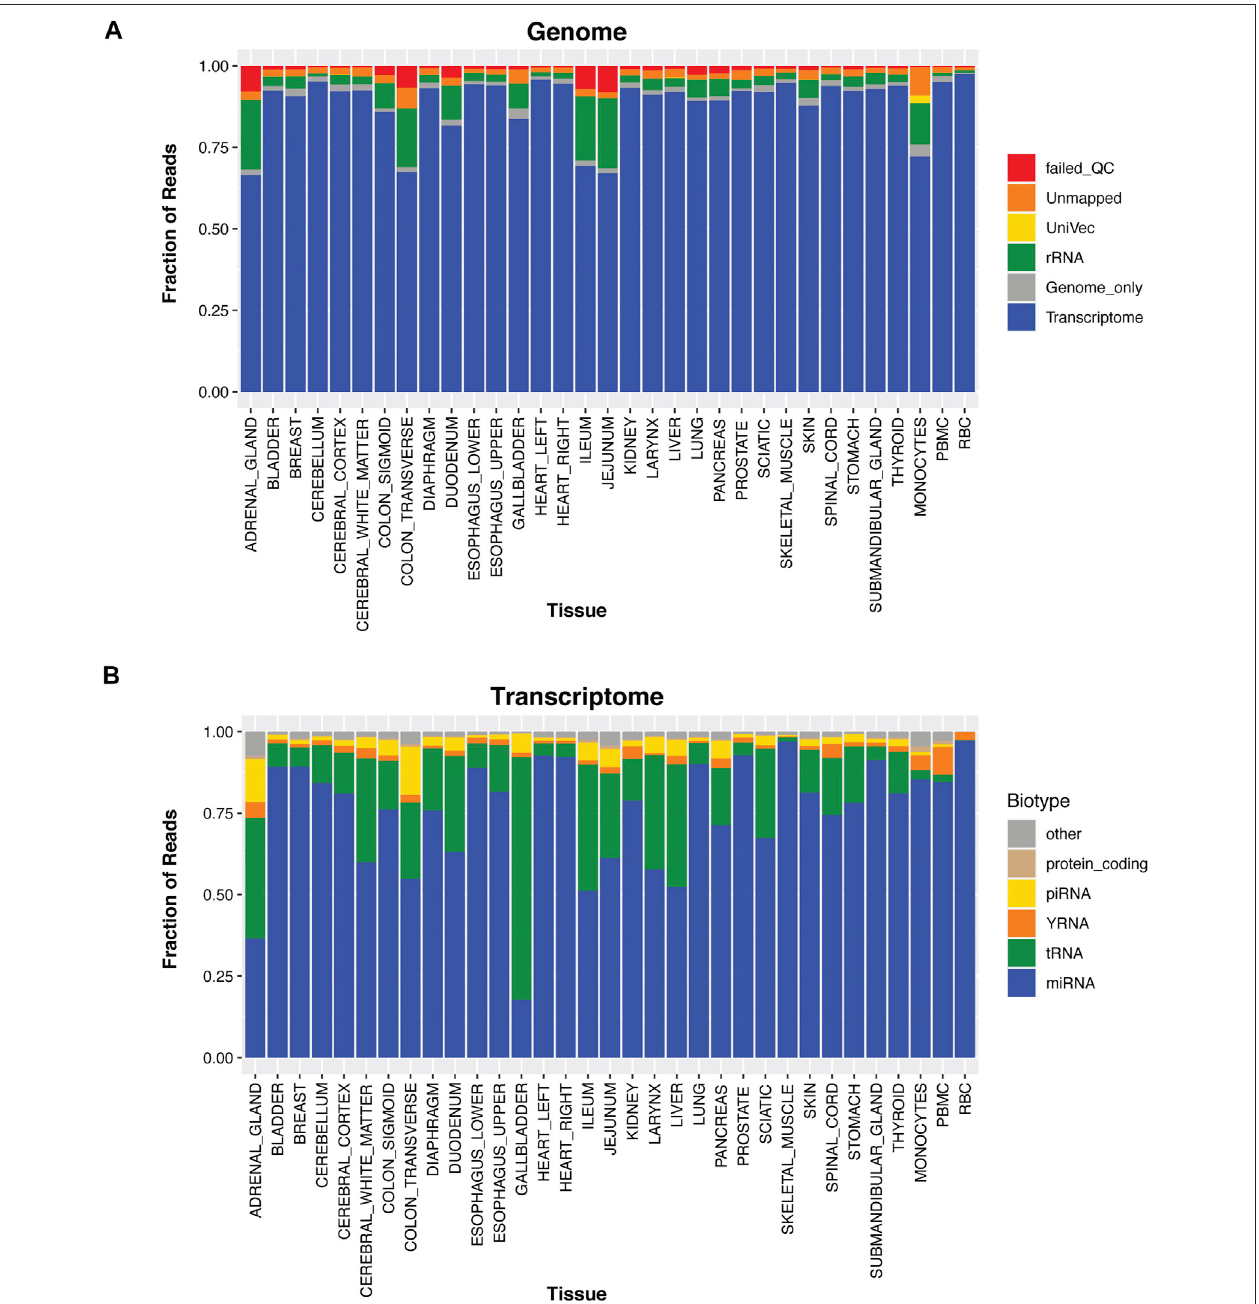
FIGURE 2 | Tissue Pro fi les. For thirty different tissues, PBMCs, monocytes, and red blood cells we isolated the RNA and sequenced their small RNA contents. In Panel (A) , the reads are aligned to the transcriptome, genome, rRNA, UniVec (contaminants), are unmapped, or reads that fail QC. In Panel (B) , the transcriptome mapped reads are removed and further broken down into small RNA biotypes; miRNA, tRNA, yRNA, piRNA, protein-coding fragments, and other (these are categories of RNA that annotate in GENCODE, lncRNA fragments, pseudogenes, etc).